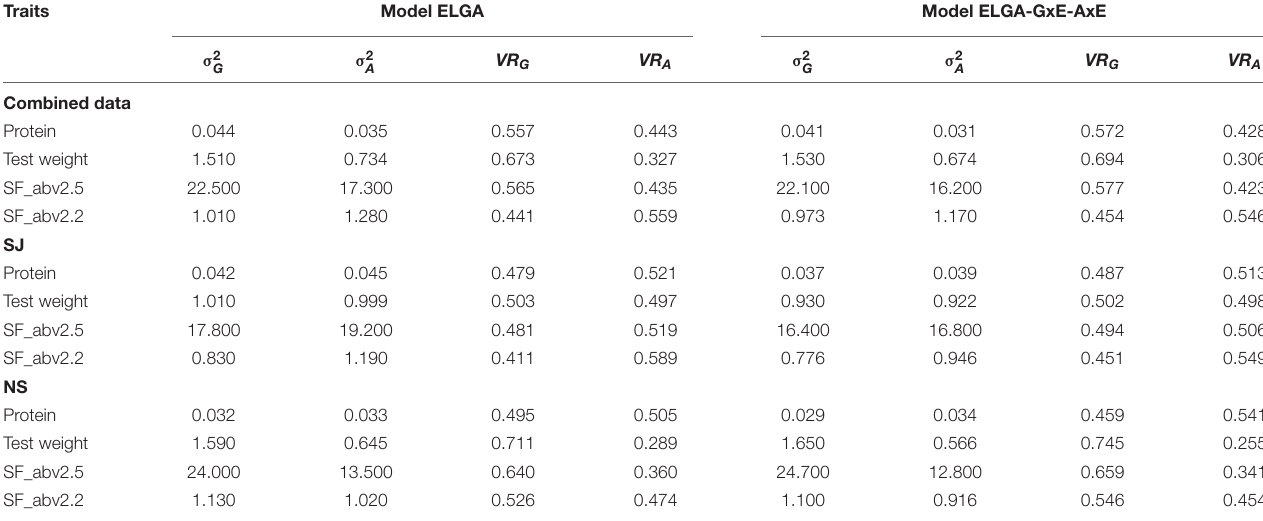
TABLE 4 | Partition of total additive genetic variance. Traits Model ELGA